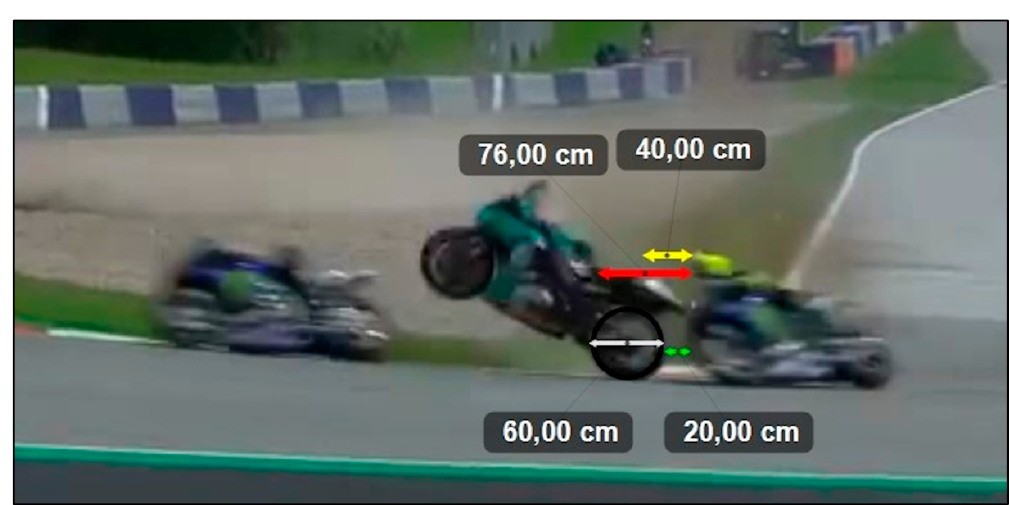
Figure 9. Rossi’s actual speed (moving an average of 5 points), 33 frames before the point where he narrowly missed colliding with Morbidelli’s careening bike. As described in the legend, the solid dots represent Rossi’s real speed and the solid triangles represent the speed in hypothetical scenario 1, while the empty dots represent the speed in scenario 2.